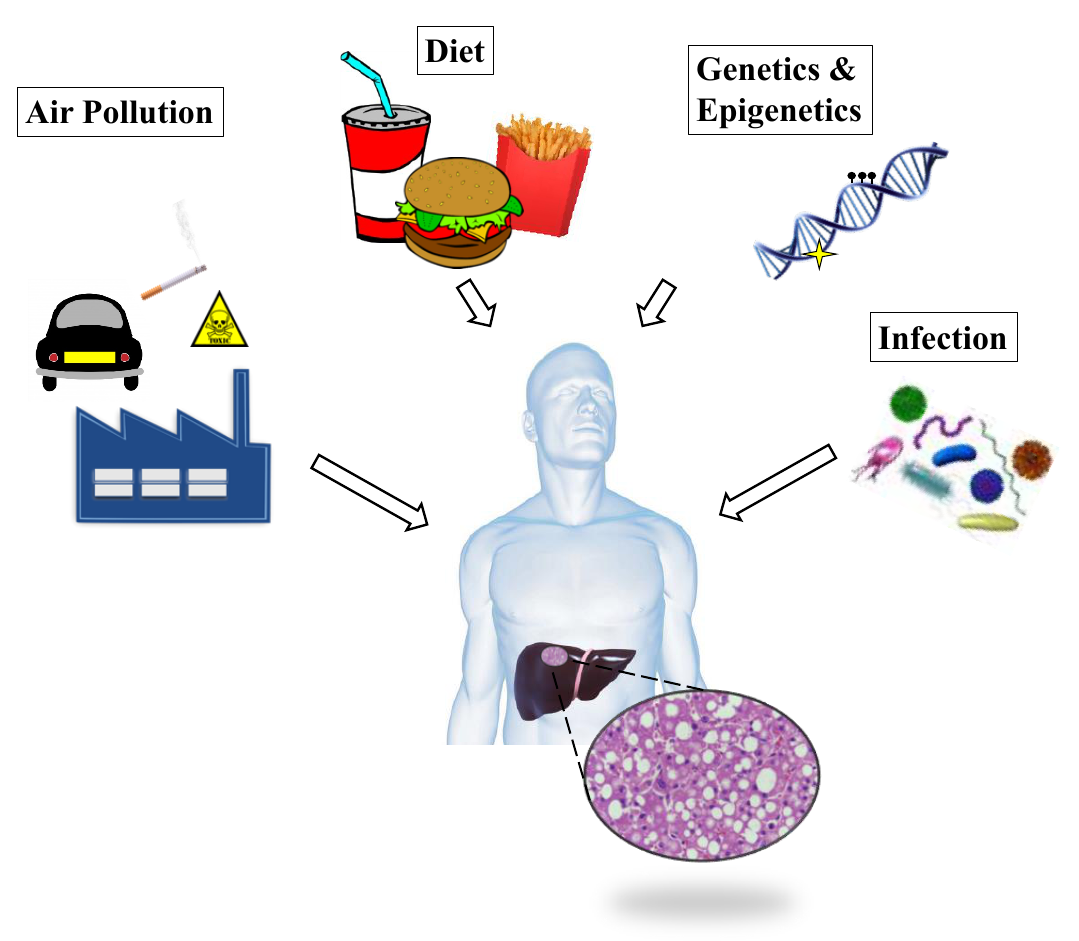
Figure 1. Pathogenesis of NAFLD (non-alcoholic fatty liver disease). NAFLD is characterized by abnormal accumulation of lipids within the hepatocytes (liver steatosis), which manifests with the development of vesicles that can displace the cytoplasm, disrupt cell constituents, and in severe cases, lead to cell rupture / burst. NAFLD is a multi-faceted disease. Multiple factors, including diet and sedentary lifestyle, exposure to toxicants and infectious agents, and genetic and epigenetic mechanisms, are now known to contribute to NAFLD development.